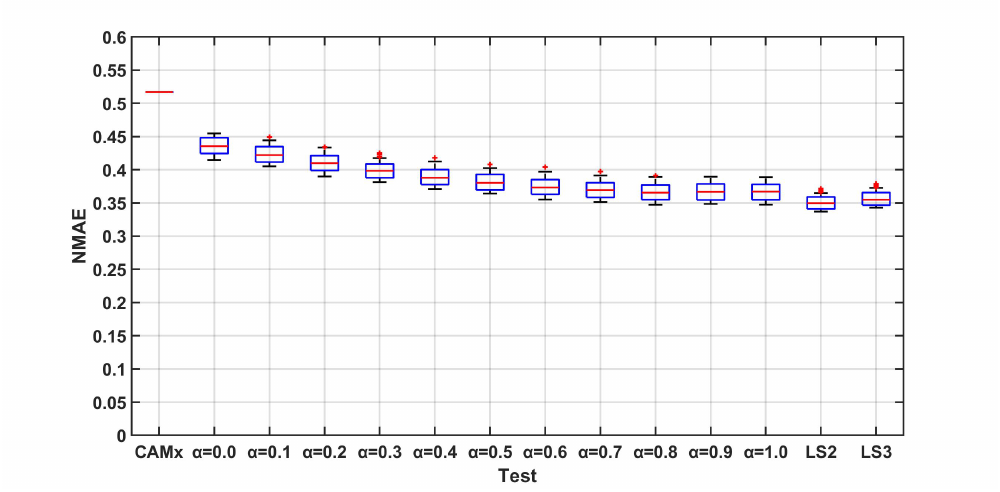
Figure 7. NMAE for the one-step-forward forecast.